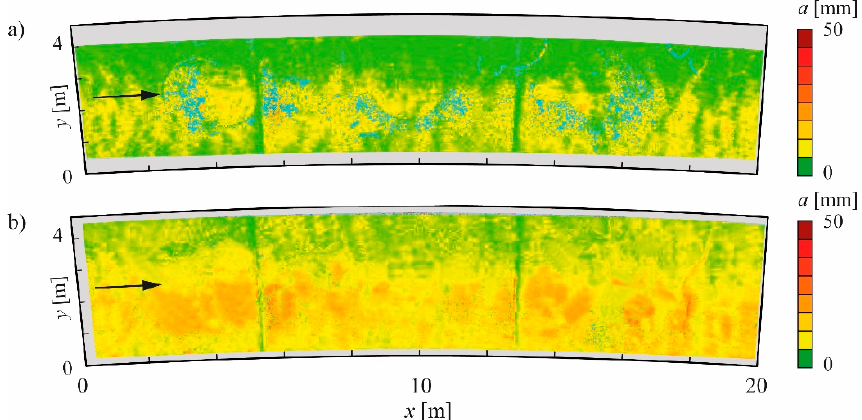
Figure 6. High-resolution abrasion maps of the 20 m long high-strength concrete test field C2 installed at test location 2 in Pfaffensprung SBT after ( a ) one and ( b ) two operational years (the grey colored areas could not be scanned due to ground water drainage installation).